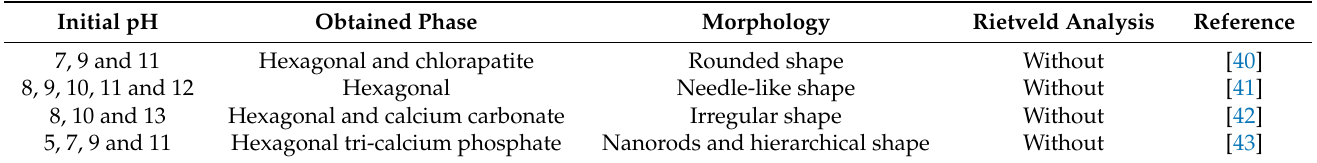
Table 7. Results obtained with similar HAp systems from the